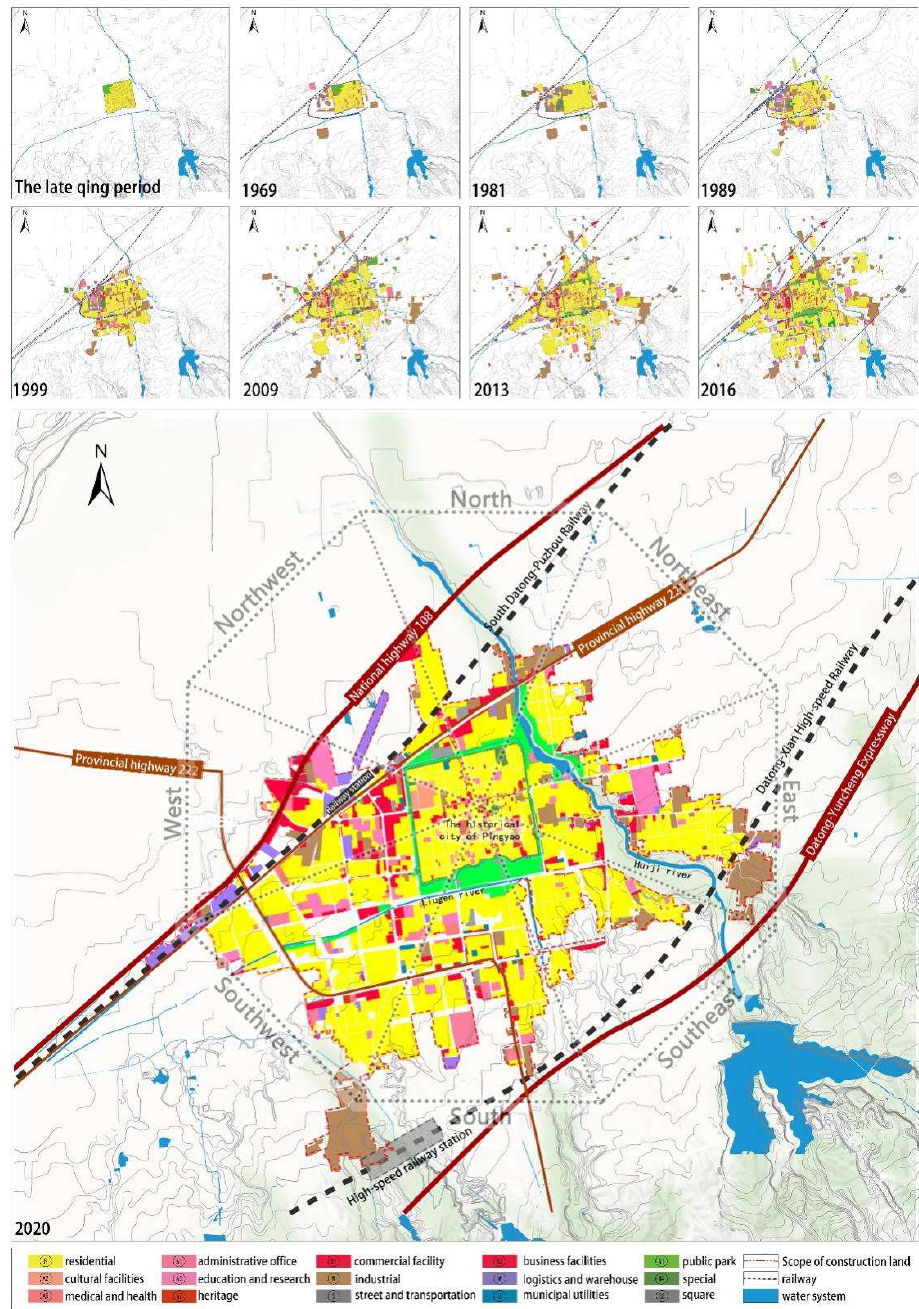
Figure 3. Land use maps in Pingyao from Qing dynasty to 2020. (Maps provided by the Department of Housing and Urban-Rural Development of Shanxi Province).